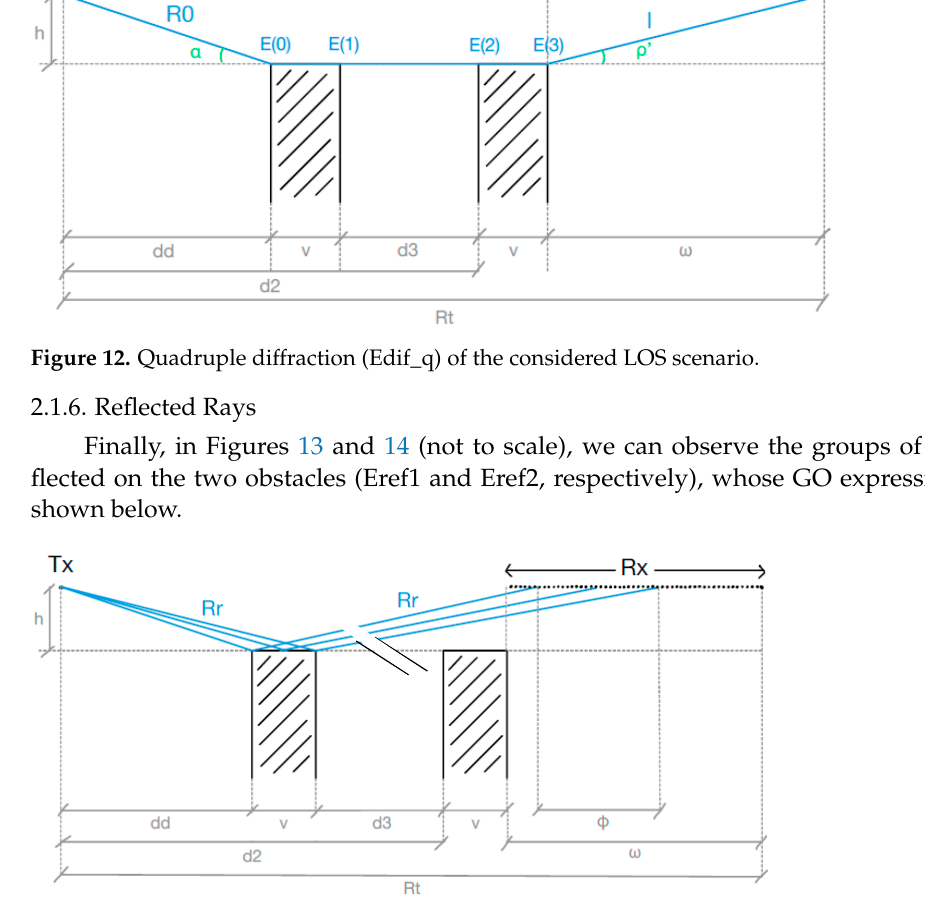
Figure 13. Reflected rays over the first obstacle (Eref1) of the considered LOS scenario.